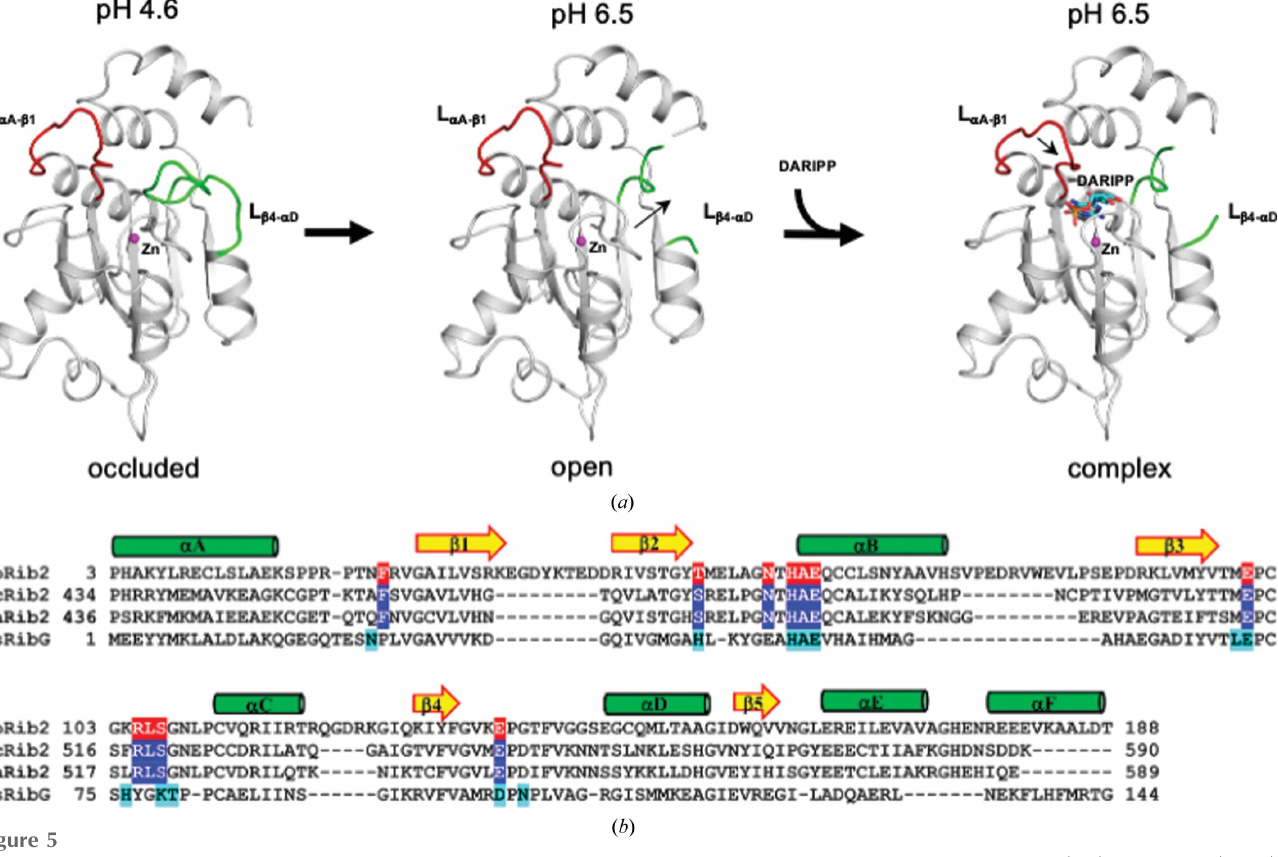
Figure 5 ( a ) Structural comparison of the occluded, open and complex structures. Structural differences were observed in the L (cid:2) A– (cid:3) 1 (red) and L (cid:3) 4– (cid:2) D (green) loops. ( b ) Sequence alignment of the deaminase domains of AoRib2, ScRib2, Candida albicans Rib2 (CaRib2) and BsRibG. The substrate-binding residues in AoRib2 and BsRibG are shown in red and cyan, respectively; those predicted in ScRib2 and CaRib2 are shown in